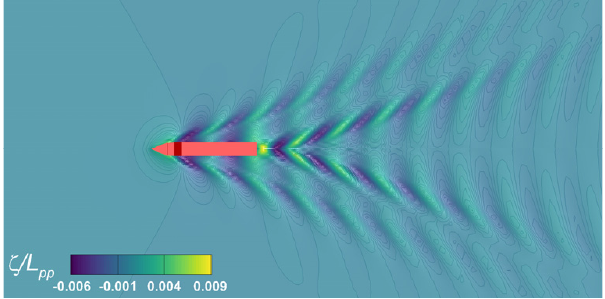
Figure 4. Free-surface profile computed in calm water at 𝐹𝑟 = 0.26 on the finest mesh G3.